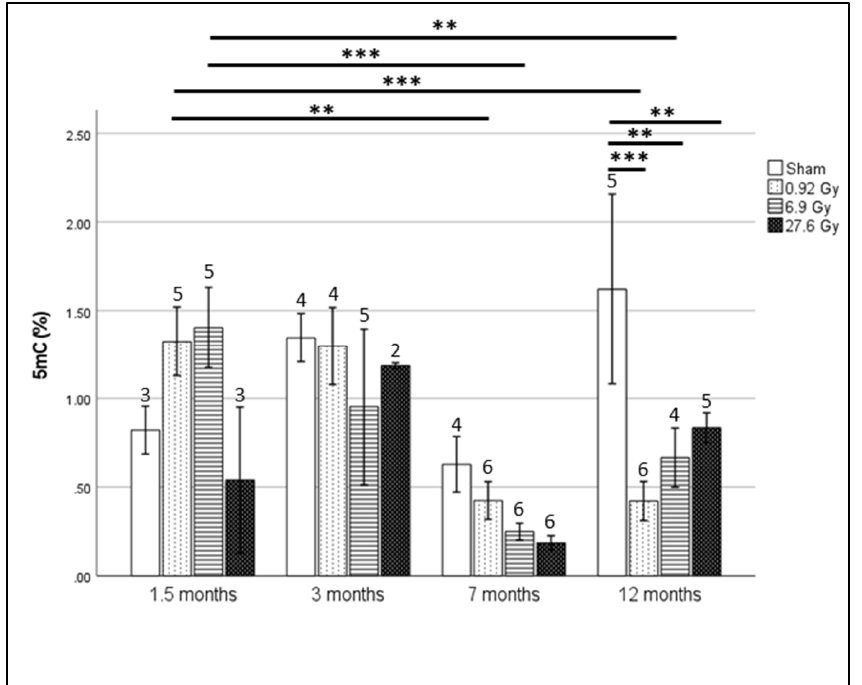
Figure 1. Percentage of 5 mC (%) after fractionated irradiation of 0, 0.04, 0.3 and 1.2 Gy resulting in total irradiation dose of 0, 0.92, 6.9 and 27.6 Gy as measured by MethylFlash Global DNA Methylation (5 mC) ELISA Easy Kit at 1.5, 3, 7 and 12 months after irradiation. Plotted values represent group means ± standard error of mean (SEM) with the number of rats per group indicated per bar. Statistical analysis was performed using SPSS generalized linear model module and multiple comparison correction was performed using least significant difference (LSD) (** = p -value < 0.01, *** < 0.001).